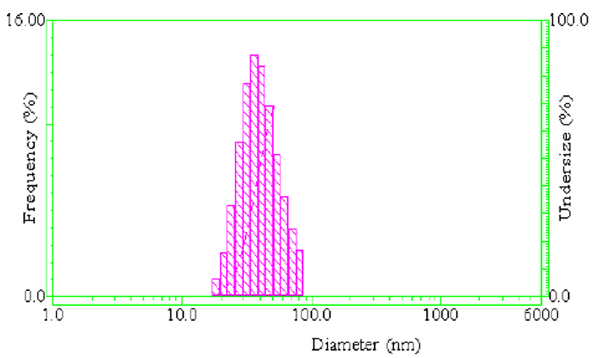
Fig. 1 Particle size distribution of CMC nanoparticle (nanoCMC)